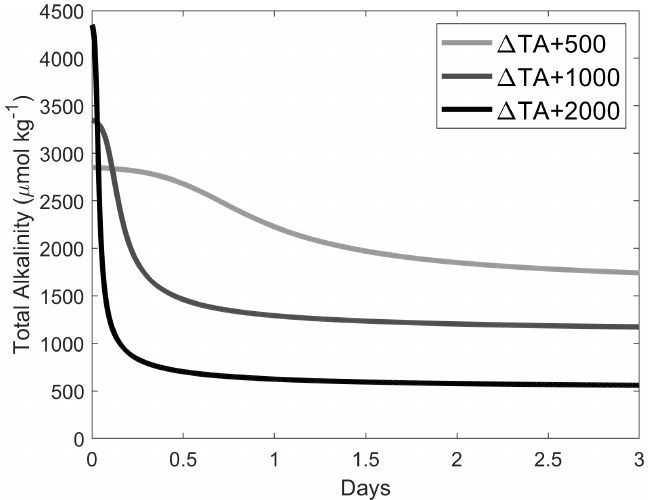
Figure A5. Simulations of TA loss due to aragonite precipitation after a TA addition of 500, 1000 and 2000µmolkg − 1 , based on (cid:127) A and surface-area-dependent precipitation rates shown in Fig. A4, assuming the initial presence of 2% of CaCO 3 in our samples, i.e. ∼ 0.37, ∼ 0.74 and ∼ 1.48mgkg − 1 for (cid:49) TA + 500, (cid:49) TA + 1000 and (cid:49) TA + 2000µmolkg − 1 , respectively. CaCO area as described in Zhong and Mucci (1989). The starting conditions were TA = 2300µmolkg − 1 , DIC = 2100µmolkg − 1 , salinity = 35 and temperature = 21 ◦